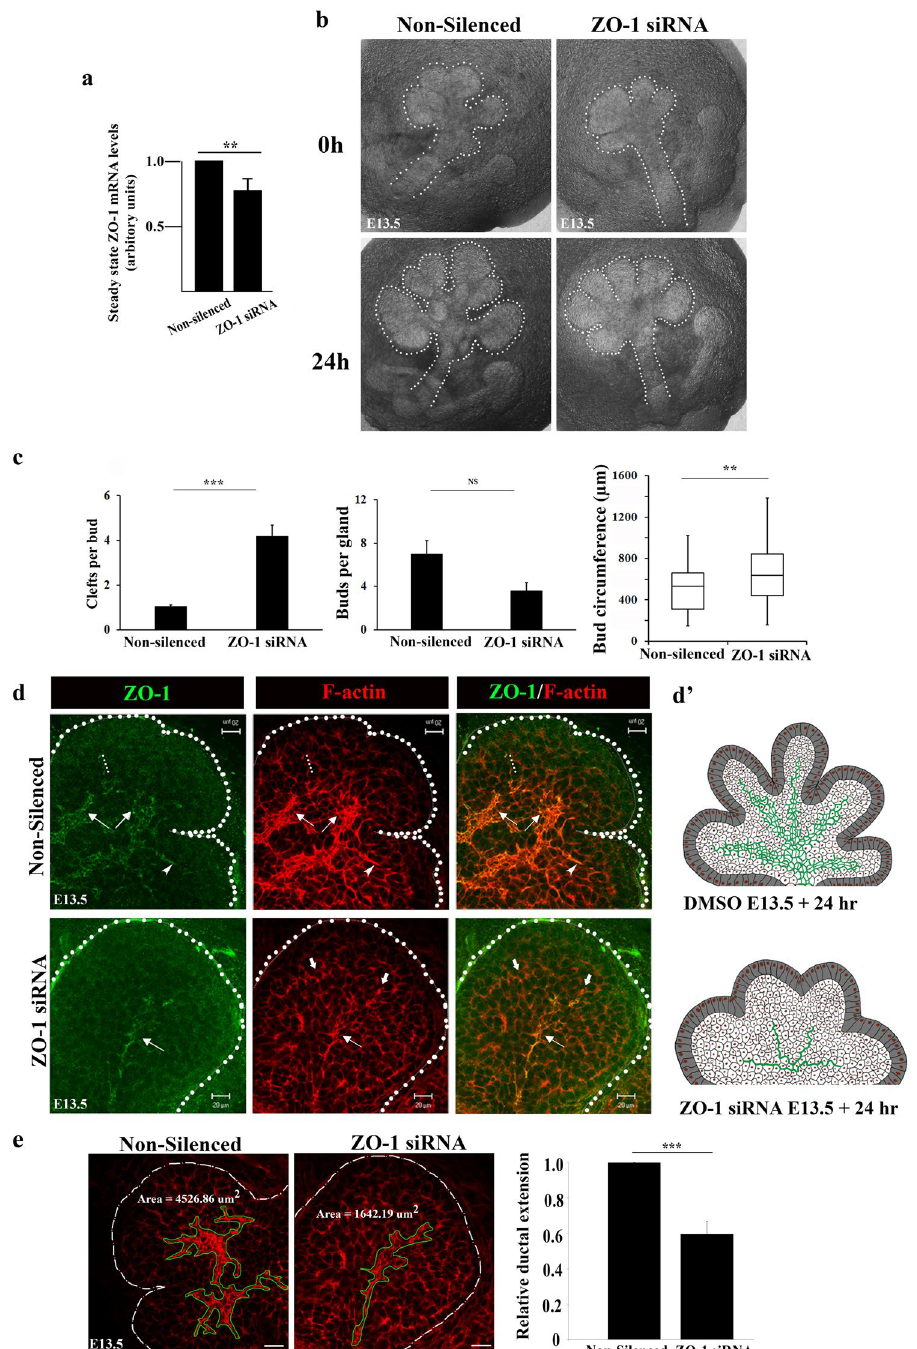
Figure 4. ZO-1 is required for F-actin expansion and extension into new buds. ( a ) Bar graph of siRNA- mediated inhibition of ZO-1 in E13.5 SMGs revealed a significant 20% knockdown of the transcript level ( p ≤ 0.01). ( b ) Bright field images of non-silenced and ZO-1 siRNA-treated E13.5 SMGs showed inhibition of cleft progression and gland expansion. ( c ) Quantification of changes in E13.5 SMG branching morphogenesis (n = 12) following ZO-1 knockdown revealed significant increases in the number of clefts ( p ≤ 0.001) and reduced bud numbers ( p ≤ 0.01) concomitant with elevated bud circumference ( p ≤ 0.01). ( d ) Immunofluorescence staining of ZO-1 (green) demonstrates the requirement for the expansion of F-actin (red) and asymmetric distribution in ductal progenitors ( → ,…). ( d’ ) A schematic depicting the effects of ZO-1 inhibition on ductal tree patterning and branching morphogenesis. Arrows ( → ) indicate loss of ductal extension in distal bud regions after siRNA-mediated ZO-1 depletion. Size bars, 20 µm. ( e ) Quantification of the area marking F-actin distribution (green outlines) in response to ZO-1 siRNA revealed significant inhibition ( p ≤ 0.001) of F-actin-mediated ductal expansion and extension into new buds (bar